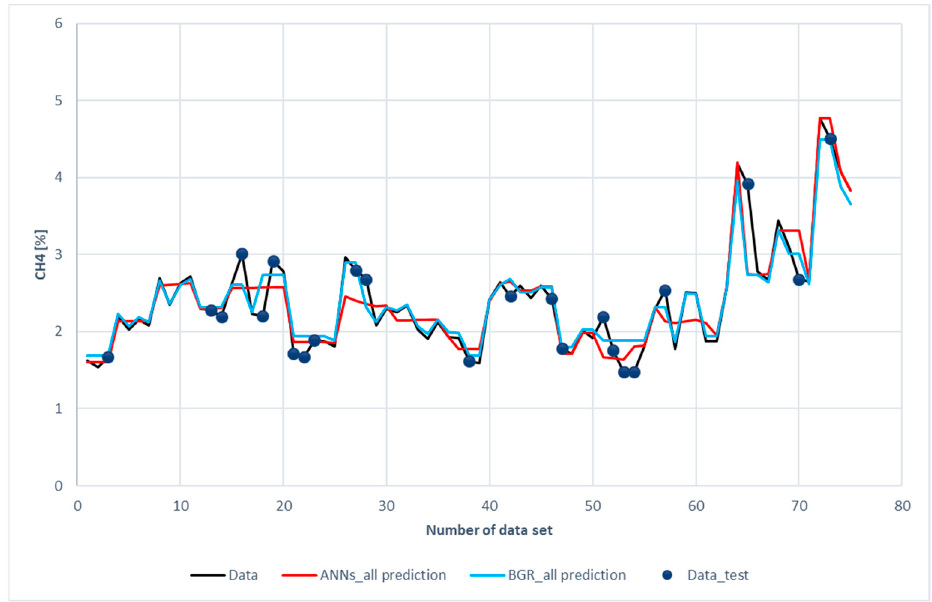
Figure 9. Comparison of CH 4 compositions among the experimental data with the ANN and GBR models.